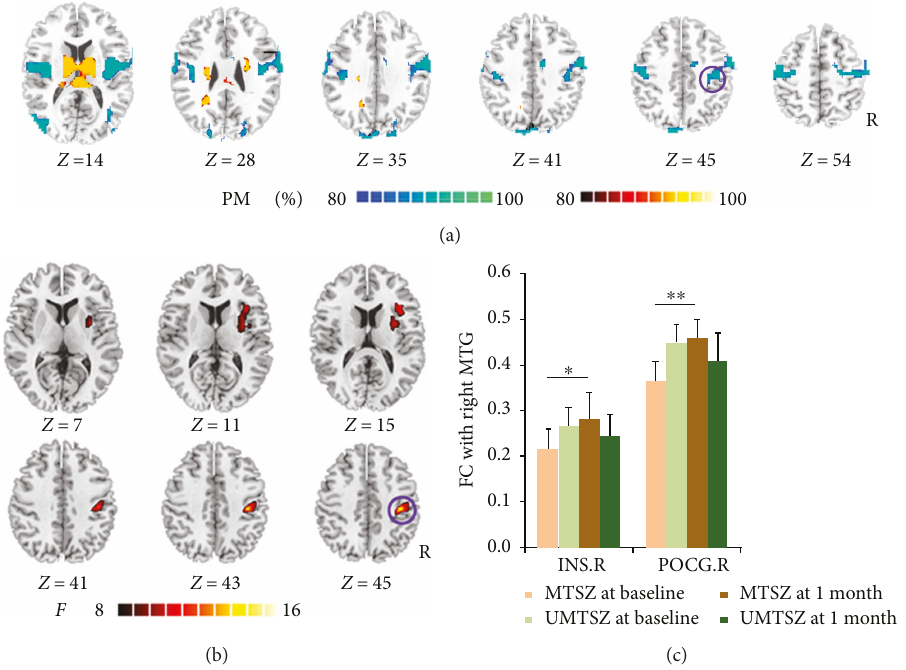
Figure 2: Music intervention ∗ time interaction on FC of the right middle temporal gyrus (MTG.R). (a) denotes that the altered FC resulted from seeded-MTG.R FC analysis in patients compared with healthy controls at baseline. The cool color indicates decreased functional connections, and the hot color indicates increased functional connections. All of the maps are shown with a probability score between 80% and 100%. (b) denotes that signi fi cant music intervention ∗ time interaction on FC was observed between the right MTG and right precentral gyrus (POCG.R), as well as the right insula (INS.R). (c) The bar maps present the between-group and within-group di ff erences in regions showing signi fi cant music intervention ∗ time interaction on FC of the MTG.R. The data were expressed as the mean value + standard error. ∗ p < 0 05 , ∗∗ p < 0 01 . The violet circles mark the same region in (a) and (b), which means the positively modulated region through music therapy in patients. Table 2: Signi fi cant music intervention ∗ time interaction on FC of the middle temporal gyrus through repeated-measure ANOVA.